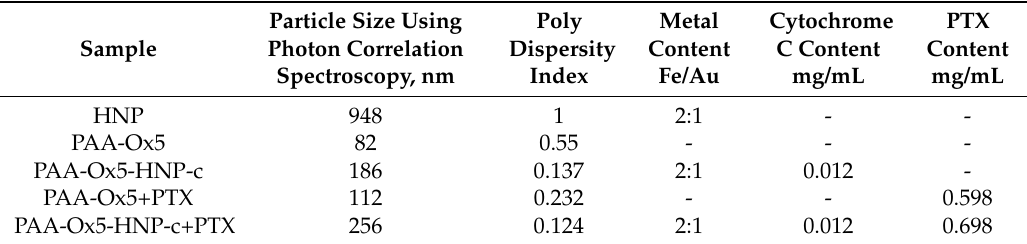
Table 1. Physical properties of particles and formulations developed ( n = 3, ± standard deviation—SD). PTX—paclitaxel; HNP—hybrid iron oxide-gold